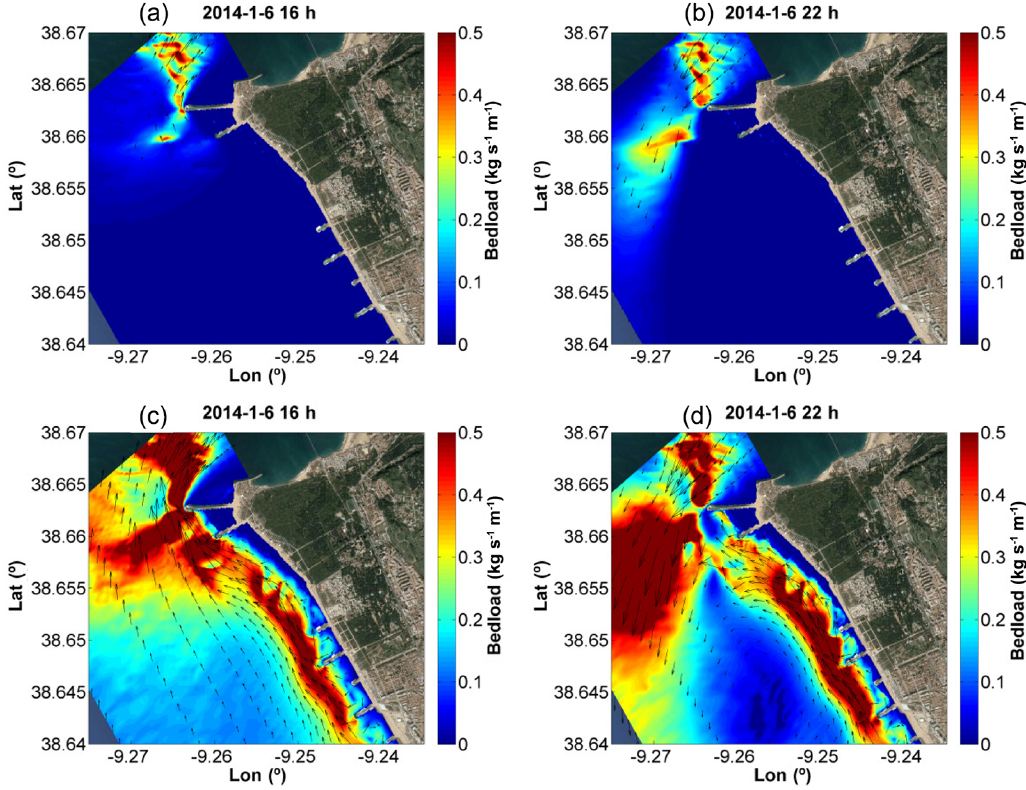
Figure 15. Results of bed load sediment transport for the scenarios without waves (a, b) and under extreme wave conditions (c, d)